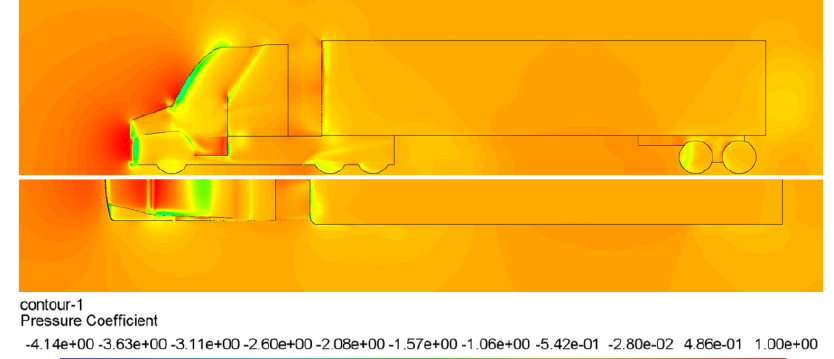
Fig. 26. Side view (top) and plan view (bottom) of the airflow pressure coefficient over the